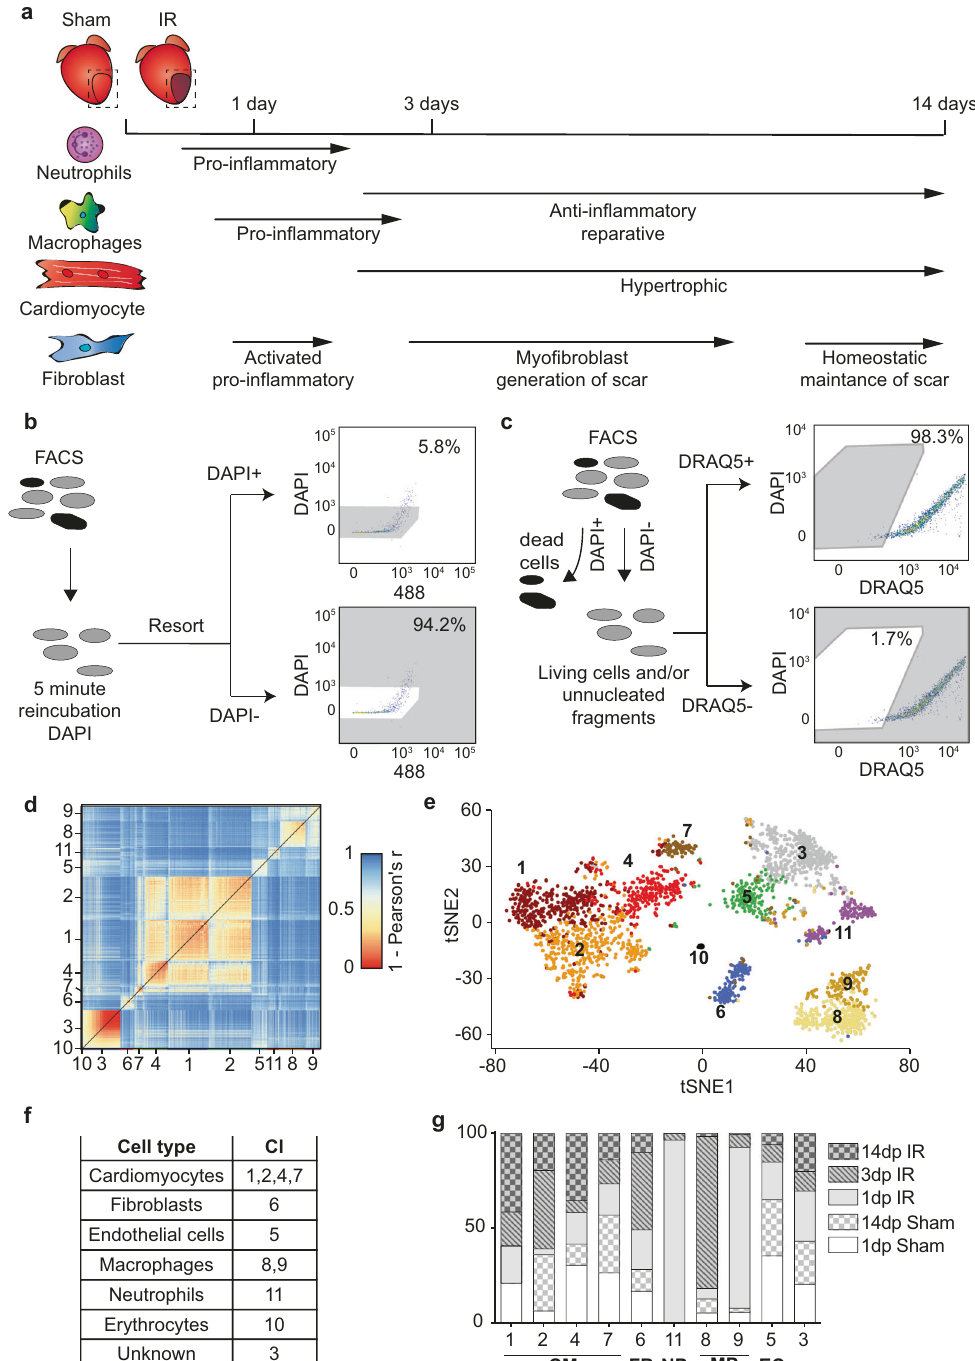
Fig. 1 Single-cell sequencing reveals changes in the cellular composition of the myocardium at different time points after ischemic injury. a Schematic of the study outline indicating time points of tissue harvest after ischemia/reperfusion (IR) injury and representation of the known cellular composition and function at these time points. b Determination of cell viability by DAPI negativity following dissociation and FACS procedure. c Schematic of the experimental setup to determine the percentage cells that are DAPI − but are nucleated as determined by DRAQ5 positivity. d Heatmap of the cell-to-cell transcriptome similarities (1 − Pearson ’ s correlation coef fi cient) of 2201 cells obtained from all conditions combined. Cells are clustered based on transcriptome similarity using k-medoids clustering. e t-Distributed Stochastic Neighbor Embedding (tSNE) plot indicating transcriptome similarities across individual cells. Different colors and numbers highlight the clusters identi fi ed by k-medoids clustering in ( d ). f Table highlighting cell types that were characterized by the clustering analysis. g Bar graph showing the proportion of cells originating from the different condition per cluster. CM cardiomyocytes, FB fi broblasts, MP macrophages, NP neutrophils, EC endothelial